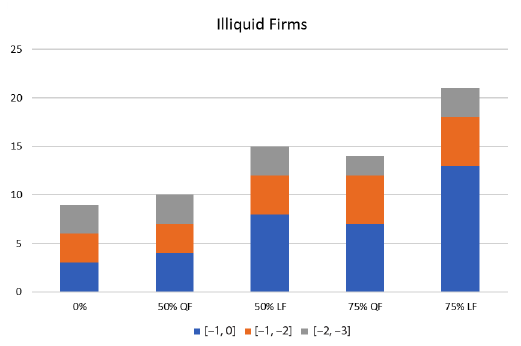
Figure 1. Firms, with quick and limited flexibility, that would become illiquid in the principal sce- nario, the conservative scenario and the extreme scenario in one, two and three